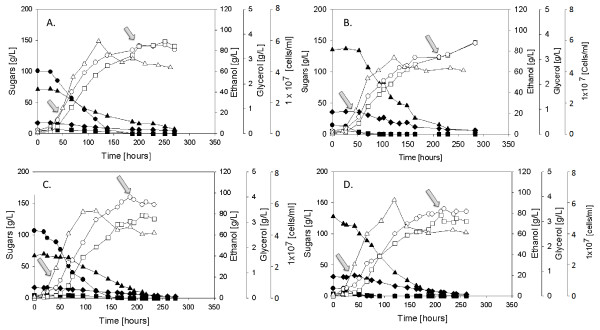
A. Control fermentations with glucose syrup supplementation; B. Control fermentations with maltose syrup supplementation; C. Glucose syrup supplemented fermentations with Flavourzyme addition; D. Maltose syrup supplemented fermentations with Flavourzyme addition. Arrows in the figures correspond to the sampling points for metabolome and transcriptome analysis of the studied fermentations. In the graphs, black circles represent the concentrations of glucose, black squares of fructose, black triangles of maltose, black diamonds of maltotriose, white squares of ethanol, white circles of glycerol and white triangles represent the numbers of cells/ml.